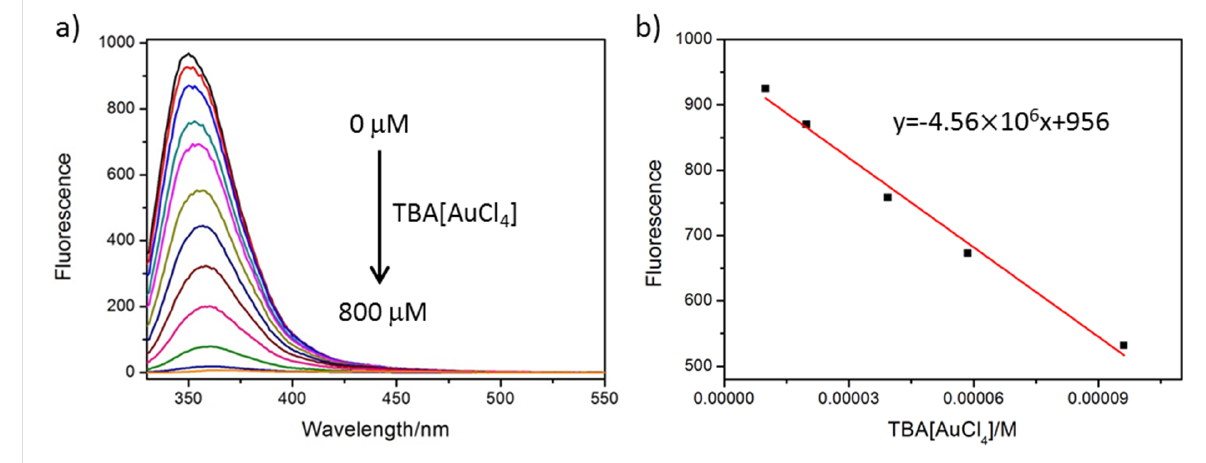
Figure 6: a) Fluorescence emission spectra of 1 (20 µM) upon addition of different amounts of TBA[AuCl 4 ] (concentration range of 0.0 − 800 µM) and then recorded in dichloromethane at room temperature ( λ ex = 310 nm). b) Plot of fluorescence intensity versus TBA[AuCl 4 ] concentration (10 − 96